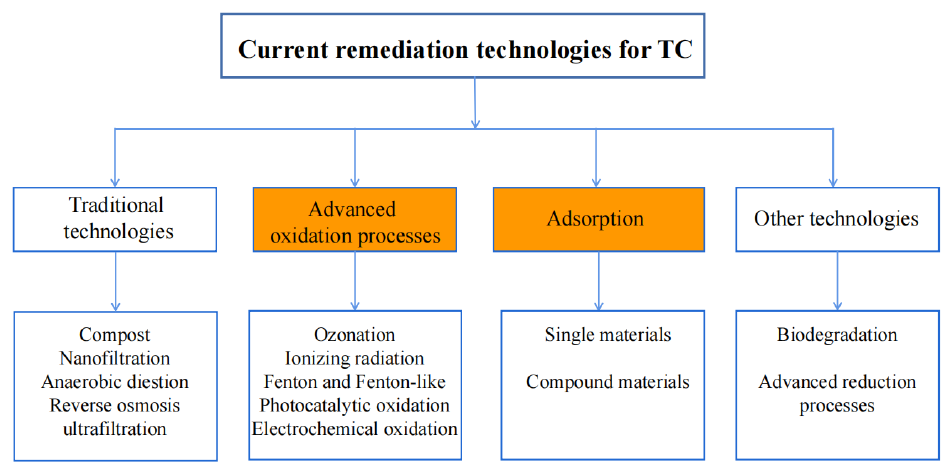
Figure 1. Overview of existing remediation technologies for controlling the TC pollution.